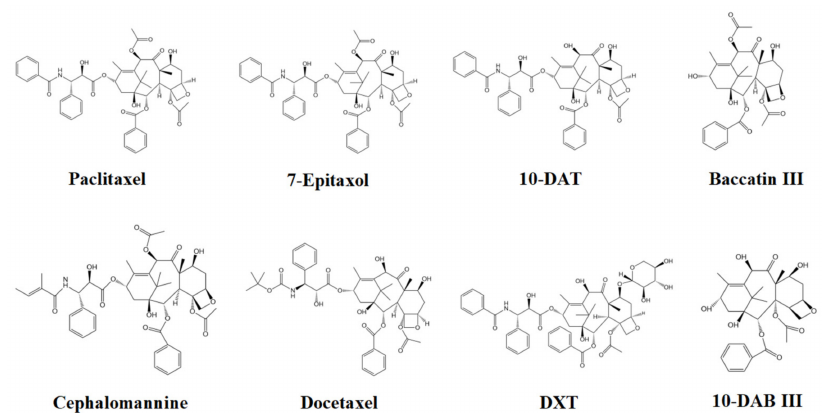
Figure 3. Chemical structures of the eight taxanes.